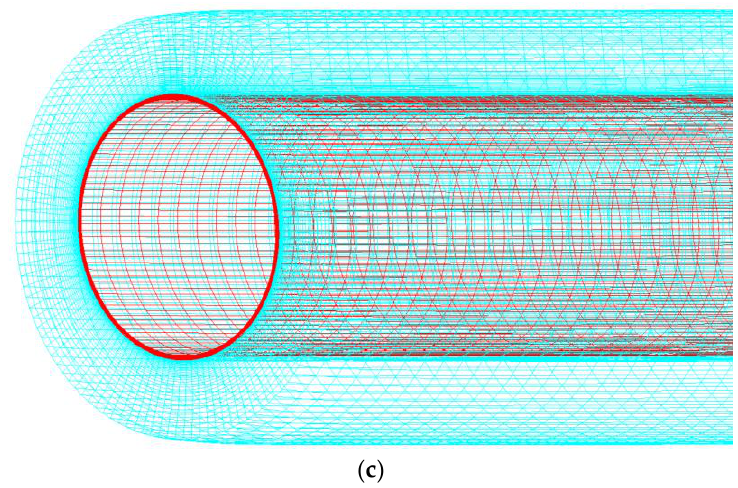
Figure 5. Grid region division and grid division: ( a ) CFD simulation domain where the green planes represent the interfaces between each section; ( b ) overall grid model; ( c ) grid near the C3 tube.